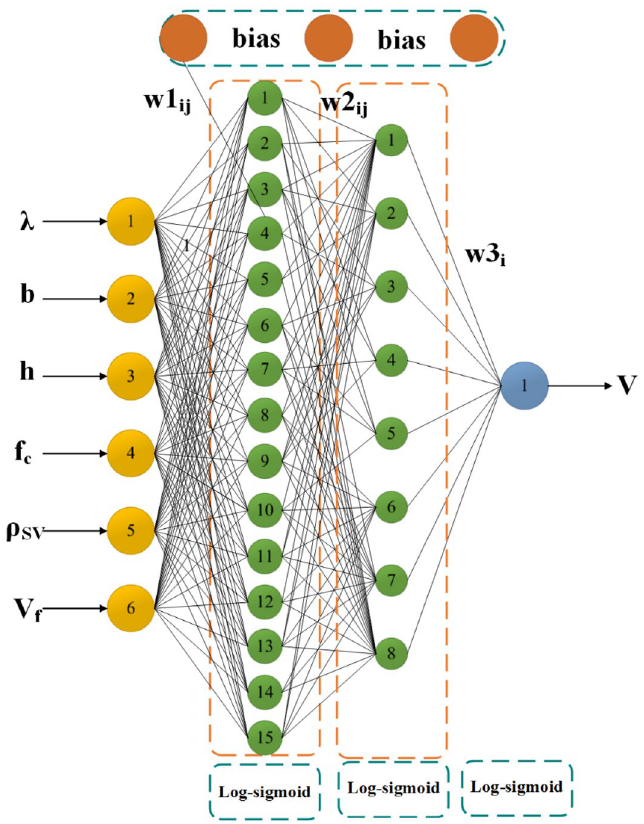
Figure 14. Schematic diagram of the optimal BPNN structure